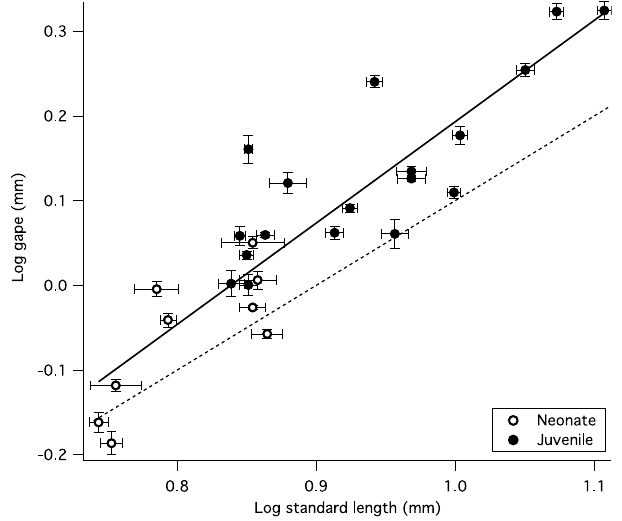
Figure 6. Positive allometric scaling of maximum gape among guppy offspring. Neonates are shown in open circles, postnatal juveniles shown in closed circles. If gape increased isometrically with body length, the points would fall along the dotted line with a slope of 1. Positive allometry indicates maximum gape is relatively and absolutely greater in larger fish. Each data point indicates mean brood gape (n = 5–6 scraping events per brood) and standard length + standard error.